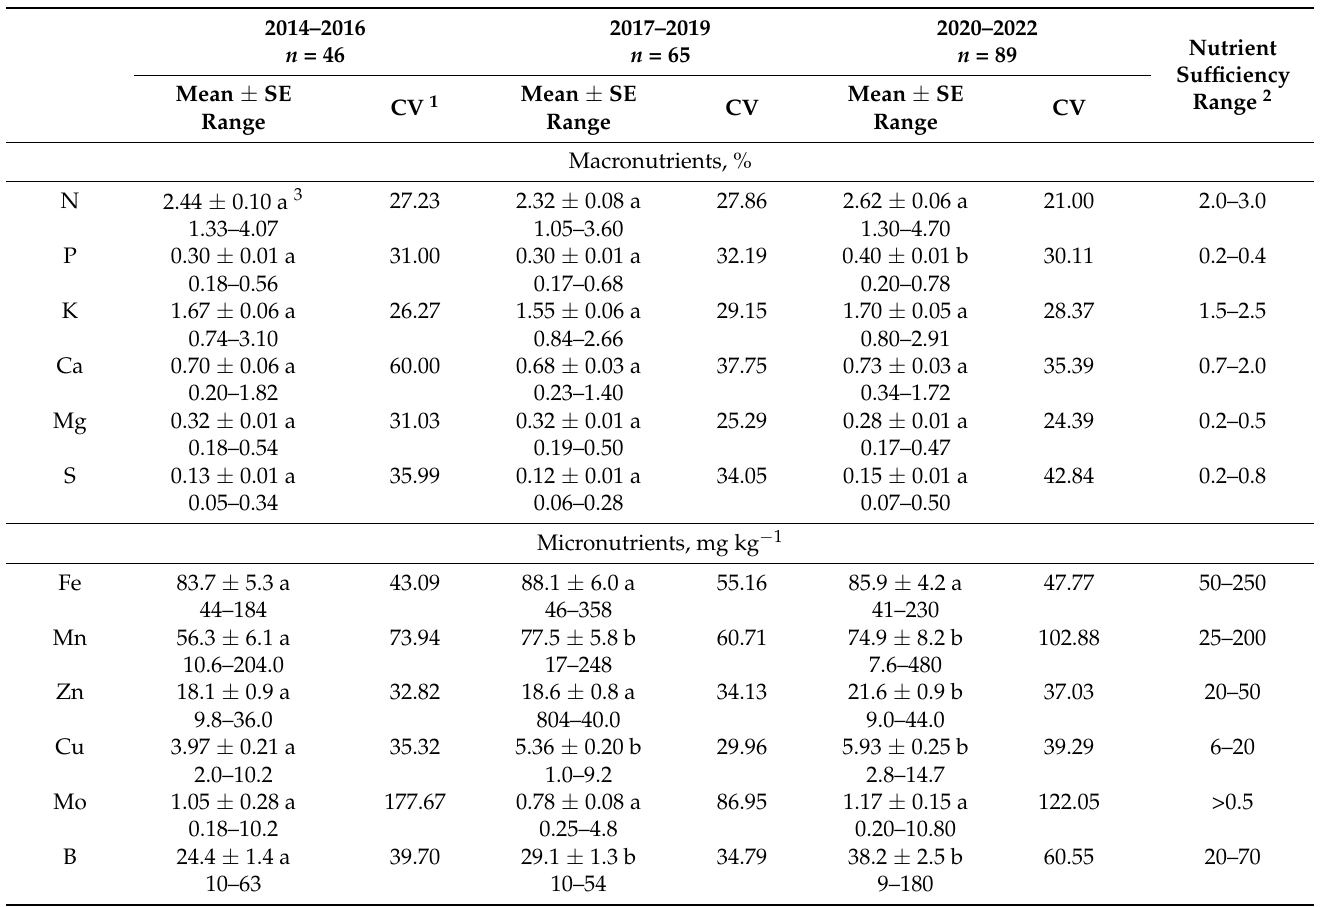
Table 1. Nutrient concentrations in air-dry strawberry leaves from commercial plantings in